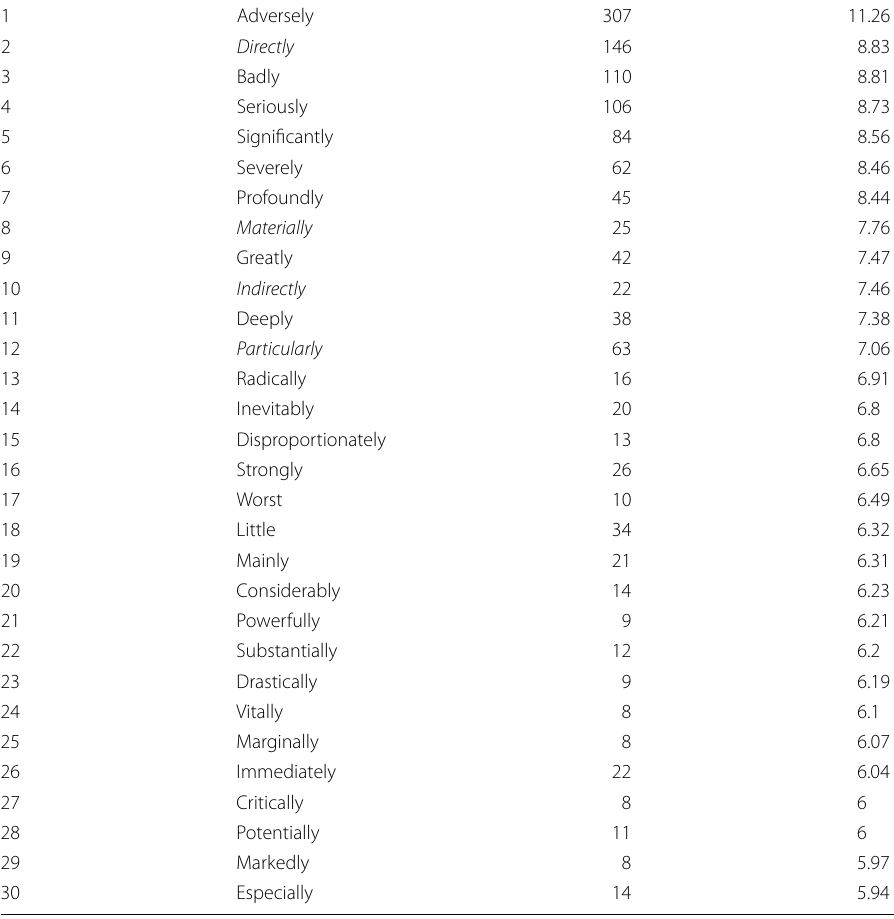
Table 2 Top 30 adverbial collocates of the verb affect